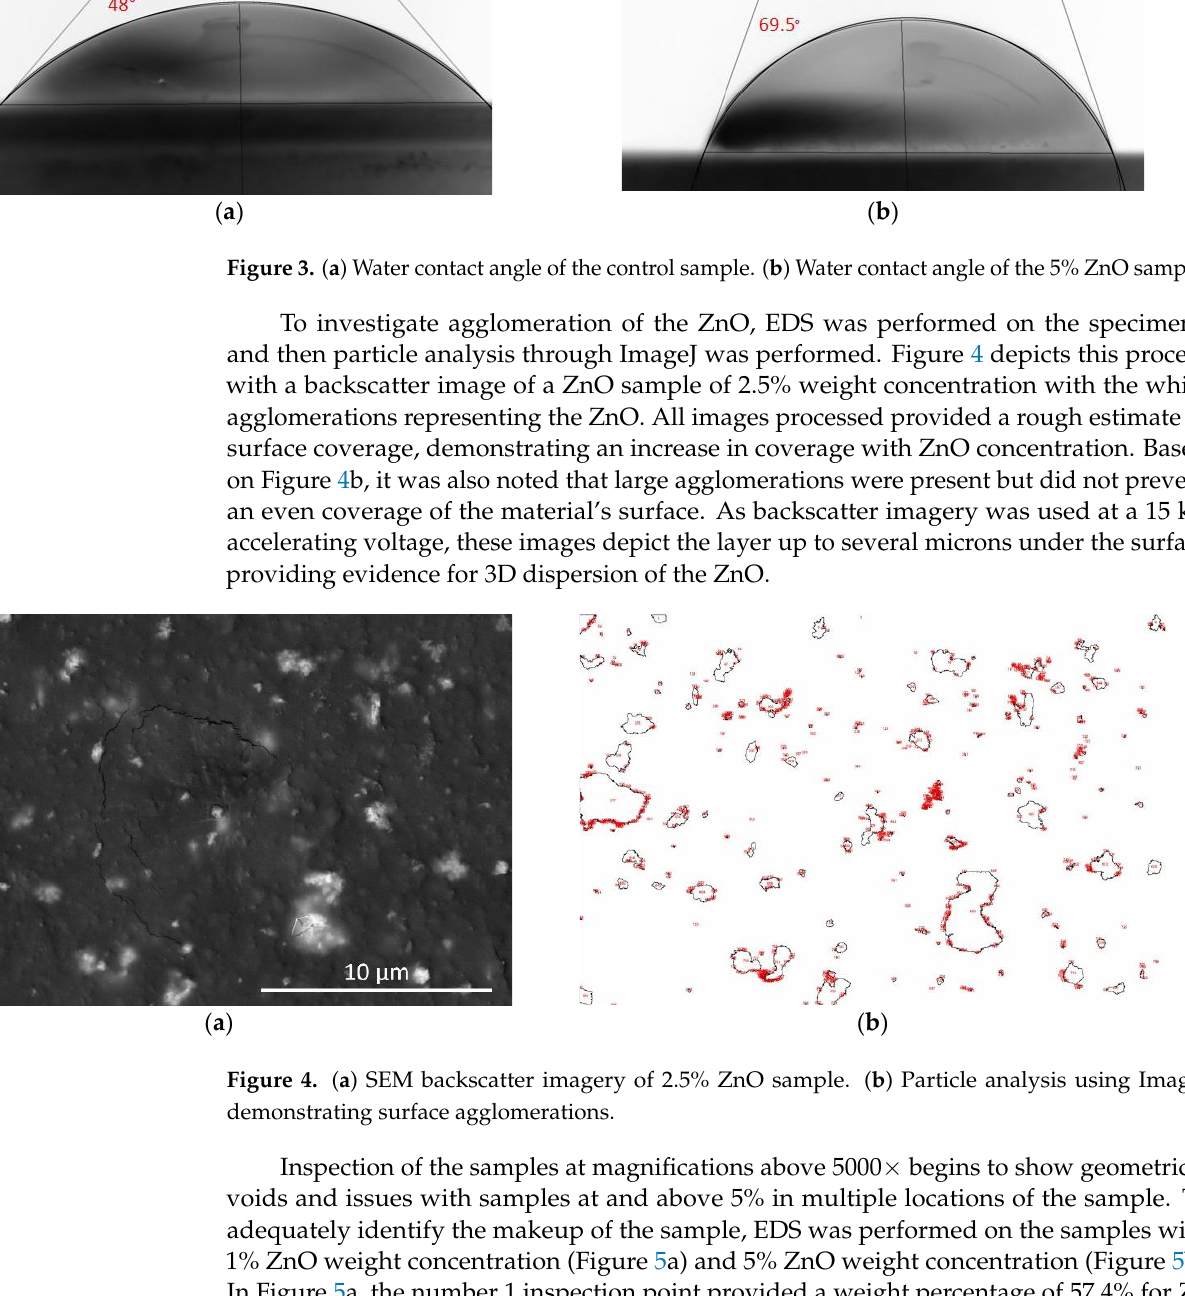
Figure 4. ( a ) SEM backscatter imagery of 2.5% ZnO sample. ( b ) Particle analysis using ImageJ demonstrating surface agglomerations.